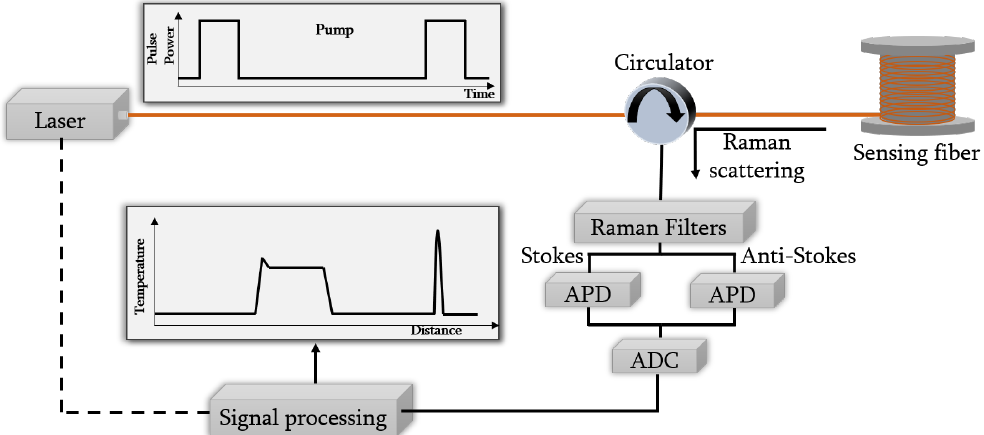
Figure 1. Schematic diagram of Raman distributed temperature sensor system based on optical time domain reflectometry (OTDR)